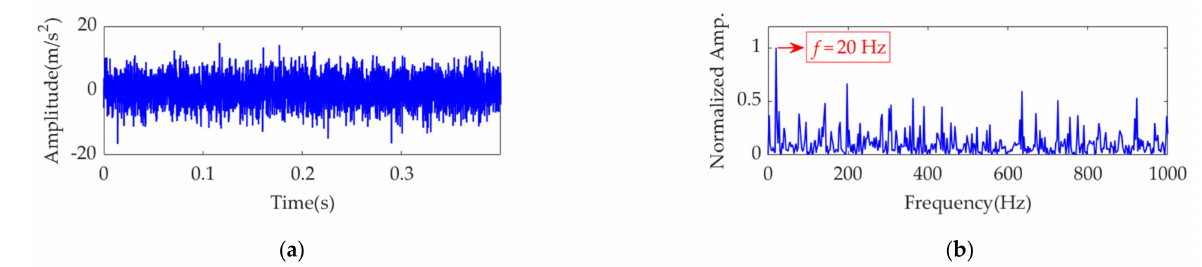
Figure 1. The simulation signal: ( a ) time–domain waveform and ( b )